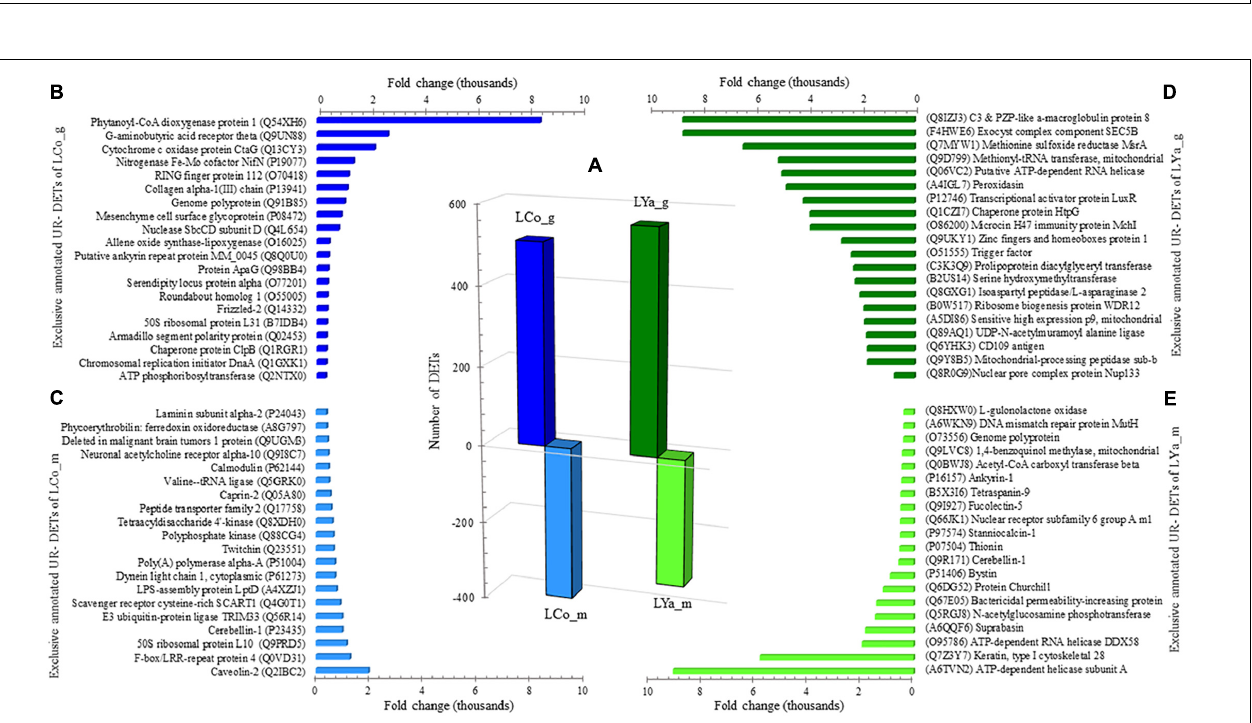
FIGURE 2 | 3D-PCA plot (A) resulting from the principal components analysis by replicating local samples from Cochamó and Yaldad. Heat map (B) representing a visual distribution by tissue and location of the up-regulated DETs of individuals from Cochamó and Yaldad. LCo, local individuals from Cochamó and LYa, locals from Yaldad. _m, mantle samples and _g, gill samples.